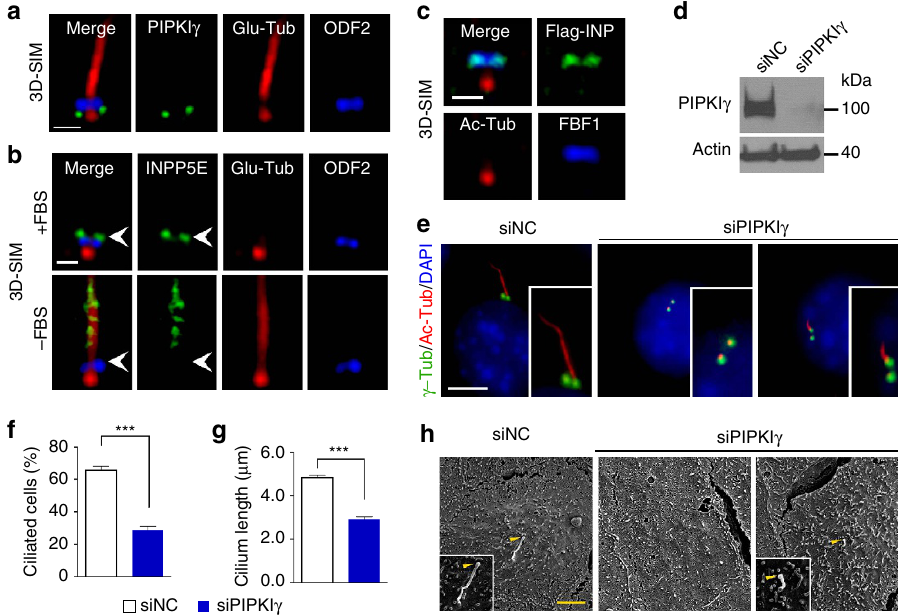
Figure 1 | PIPKI c is required for ciliogenesis. ( a – c ) RPE-1 cells were treated as described below, subjected to indirect immunofluorescence (IF) labelling with indicated antibodies, and than analysed with three-dimensional structured illumination microscopy (3D-SIM). ( a ) Serum-starved RPE-1 cells; ( b ) RPE-1 cells before ( þ FBS) and after ( (cid:2) FBS) 24h serum starvation; ( c ) RPE-1 cells expressing Flag-tagged INPP5E (Flg-INP).Ac-Tub, acetylated a -tubulin; Glu- Tub, polyglutamylated tubulin. ( d ) IMCD3 cells were treated with negative control (siNC) or PIPKI g -specific (siPIPKI g ) siRNAs for 48h. ( e – g ) IMCD3 cells described in d were serum starved for 24h and subjected to IF. Nuclei were visualized by DAPI staining (blue). Insets show magnified images of primary cilia. g -Tub, g -tubulin. Percentage of ciliated cells ( f ) and cilium length ( g ) in each group ( n 4 200) were quantified from three independent experiments and plotted. Error bars represent s.d. in f and s.e.m. in g . *** P o 0.001. ( h ) Cells described in d were analysed by scanning electron microscopy. Arrowheads indicate the ciliary base. Scale bar, 0.5 m m in a – c ; Scale bar, 5 m m in e and h . NATURE COMMUNICATIONS|7:10777|DOI: